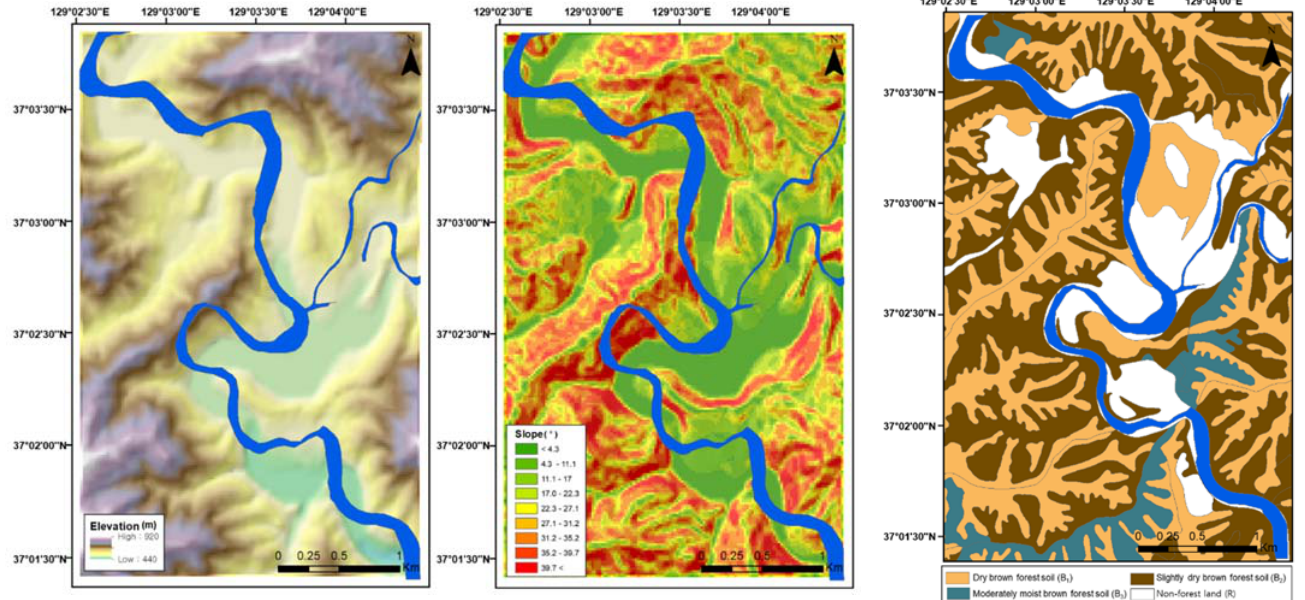
Figure 2. Maps showing the spatial distribution of elevation (m), slope (degree), and soil type in the study area. The climate of Bonghwa is continental, with warm and moist summers and cold and dry winters. The mean annual temperature is 9.9 ◦ C and the high and low mean temperatures are recorded as 28.6 ◦ C and − 10.3 ◦ C in August and January, respectively.